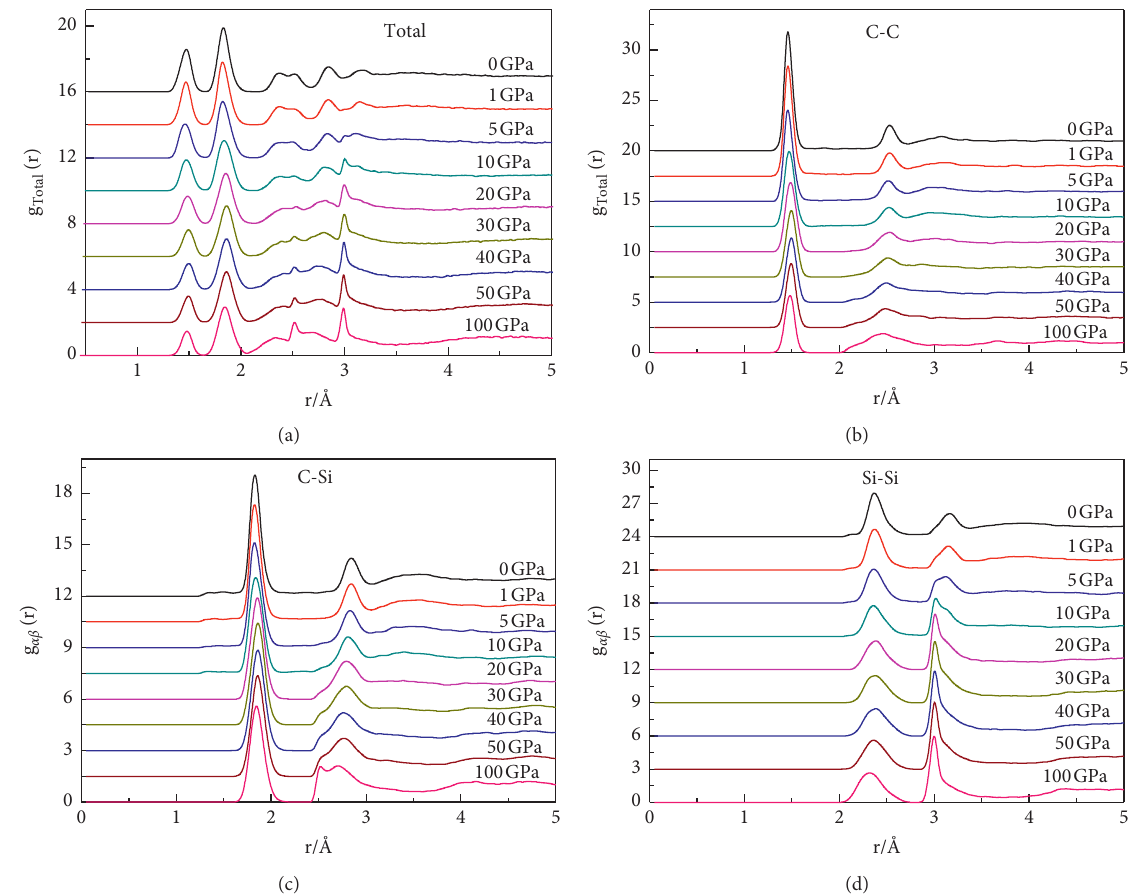
Figure 4: RDF after solidification of SiC under different pressures